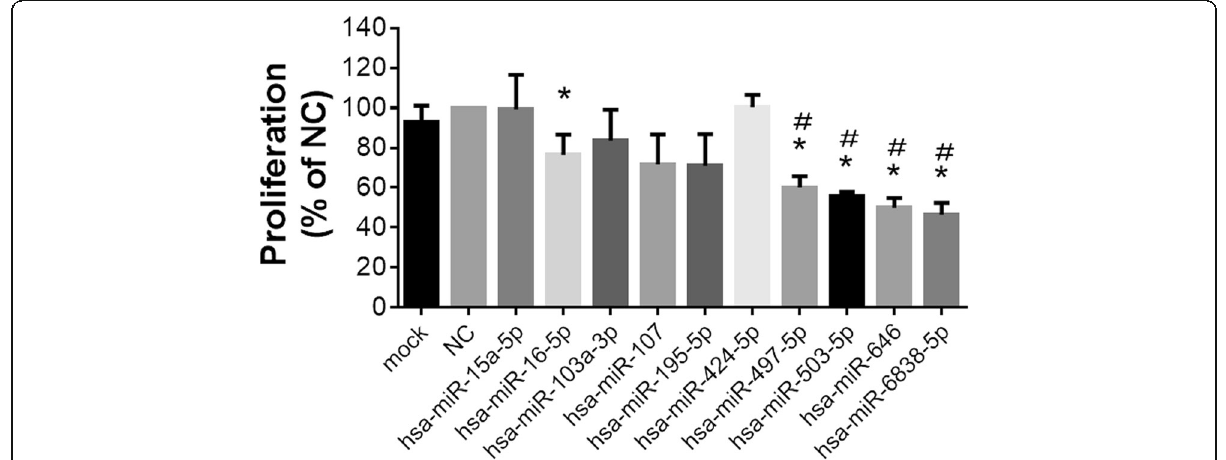
Fig. 6 Cell proliferation during gain of miR-15/107 function in SW982 cells. Cell proliferation was detected by using CCK-8 assay after the SW982 cells were transfected with 10 nM miRNA mimic of the miR-15/107 family members for 48 h. Bar: mean ± SEM from 3 independent cell experiments, and 4 cell replicates were used in each cell experiment. *: p < 0.05 vs. NC (scramble miRNA mimic as negative control), #: p < 0.05 vs. mock (vehicle